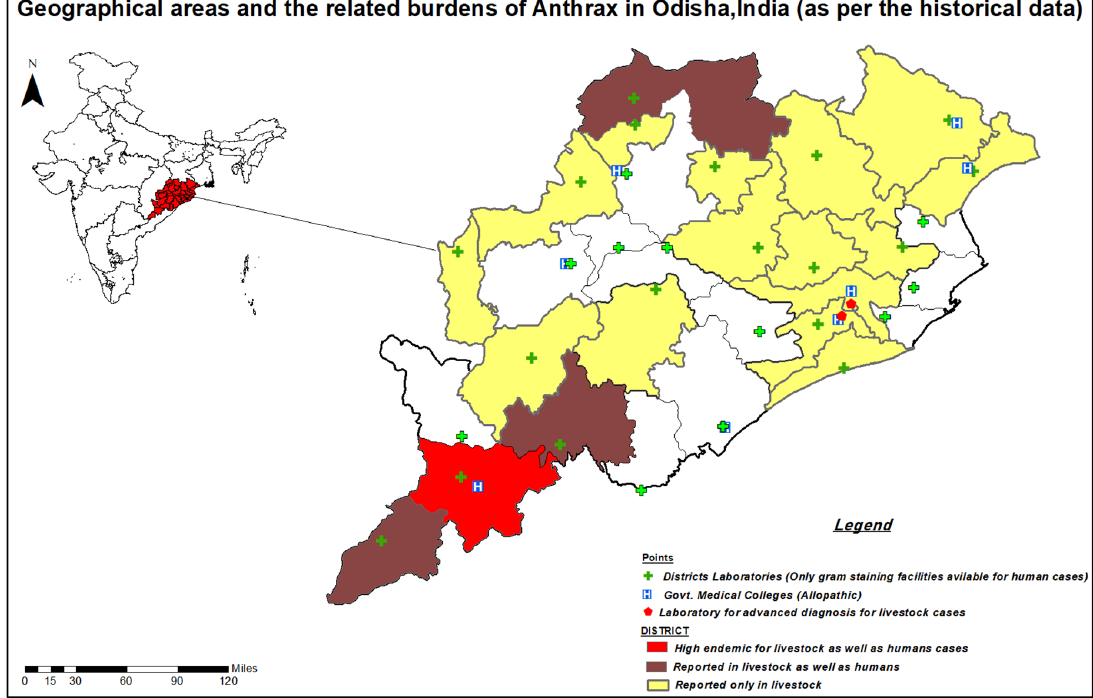
Figure 1. Geographical areas and the related burdens of Anthrax in Odisha, India.